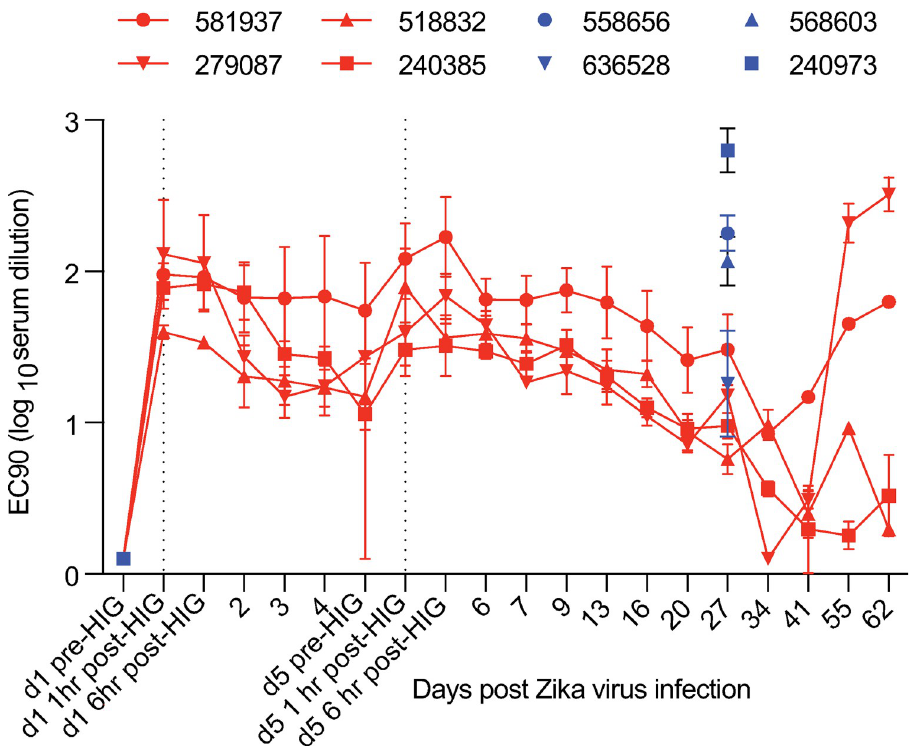
Fig 4. Plaque reduction neutralizing antibody titers (90%) of ZIKV-IG and placebo-IG-treated animals. Longitudinal neutralizing antibody titers of ZIKV-IG-treated animals (red). Placebo-IG PRNT90 titers were measured at 0 and 27 dpi only (blue). Dotted vertical lines represent the time point 1 hour post-ZIKV-IG infusion for reference. Mean titers with 95% CI are plotted.